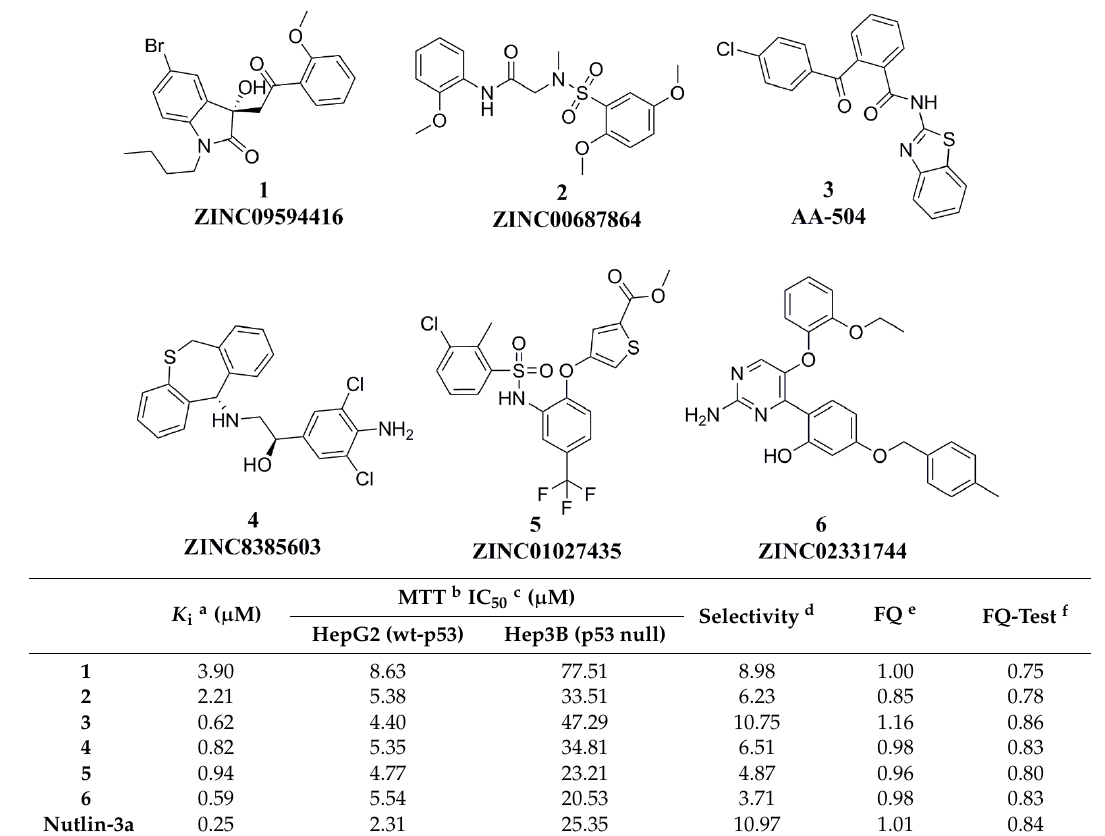
Molecules 2018 , 23 , x FOR PEER REVIEW Table 1. Binding constants ( K i ) of the two compounds and IC 50 values of in vitro antitumor activity.